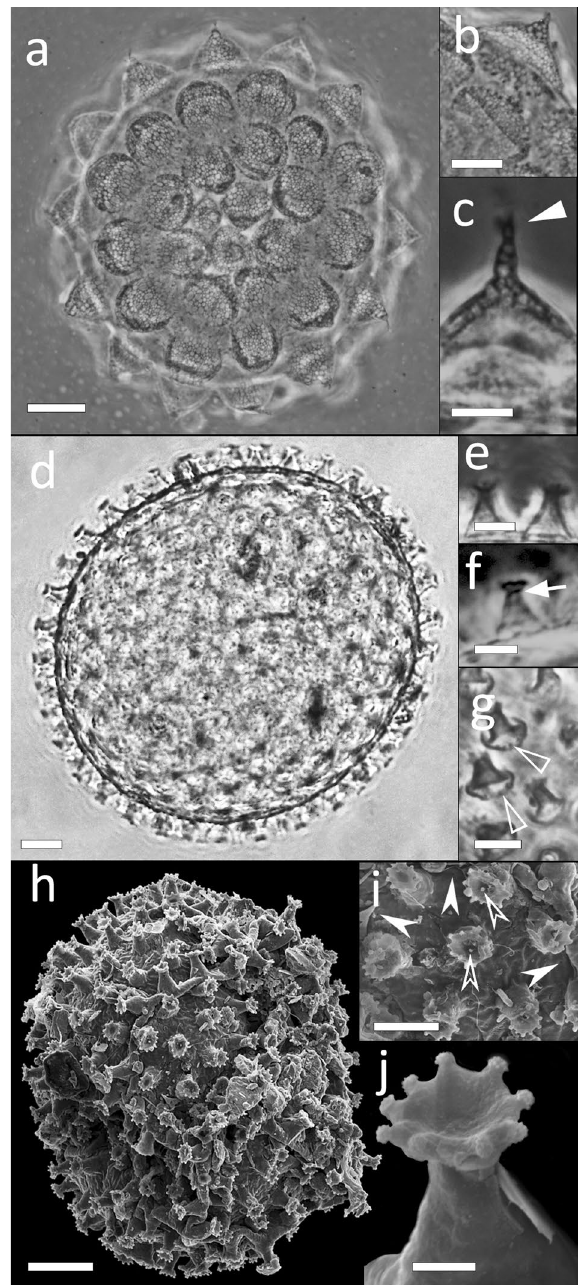
Figure 2. Eggs of Mesobiotus emiliae sp. nov. and Xerobiotus gretae sp. nov. ( a – c ) M. emiliae sp. nov. ( a ) iIn toto , ( b ) Processes surface detail, ( c ) Abnormal processes (lateral view). ( d–j ) X. gretae sp. nov. ( d ) In toto , ( e , f ) Processes (lateral view), ( g ) Processes (frontal view), ( h ) In toto , ( i ) Processes and surface detail, ( j ) Process (fronto-lateral view). Arrowhead: tuft of filaments on the tip of the egg process; arrow: septum dividing trunk and terminal disk of egg process; empty arrowhead: crown of dots at process base; indented arrowheads: pore on egg surface; empty indented arrowheads: indentation-like structures (provided with granular ornamentation) occurring in the upper surfaces of the disk. ( a–g ) LM, PhC; ( h – j ) SEM. Scale bars ( a , d , h ) 10 µm; ( b , c , e–g , i ) 5 µm; ( j ) 1